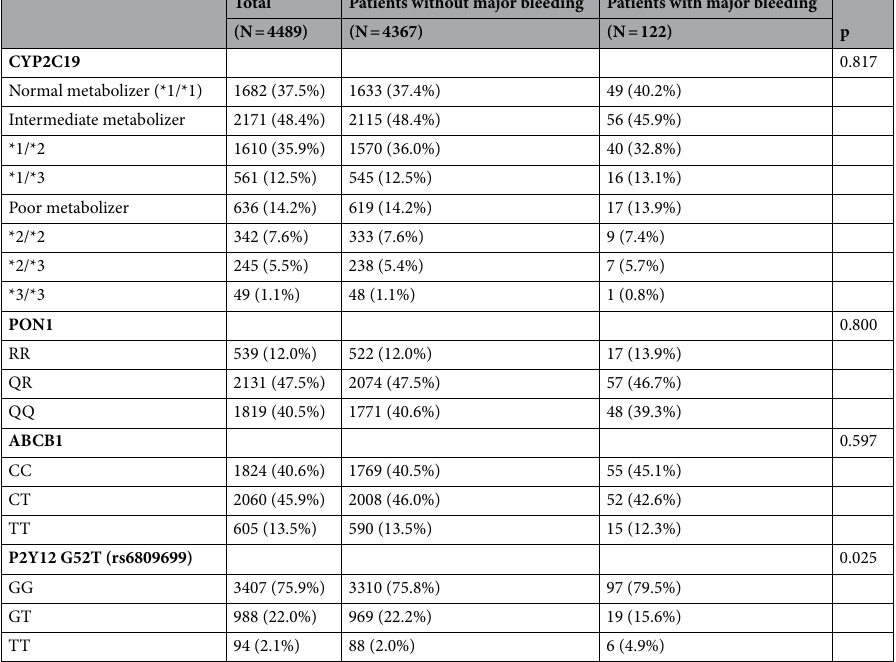
Table 2. Genetic variants of four major single-nucleotide polymorphisms according to the major